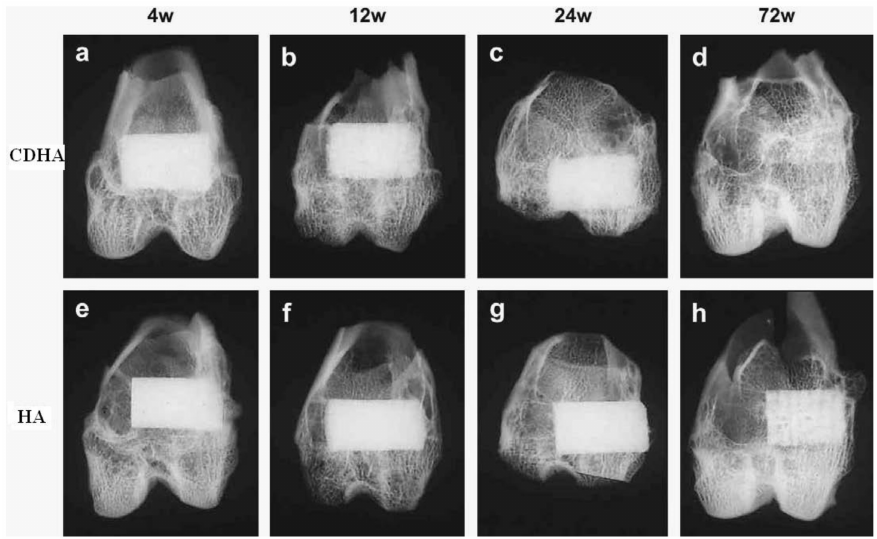
Figure 2. Soft X-ray photographs of the operated portion of the rabbit femur. Four weeks ( a ), 12 weeks ( b ), 24 weeks ( c ), and 72 weeks ( d ) after implantation of CDHA; 4 weeks ( e ), 12 weeks ( f ), 24weeks( g ), and72weeks( h